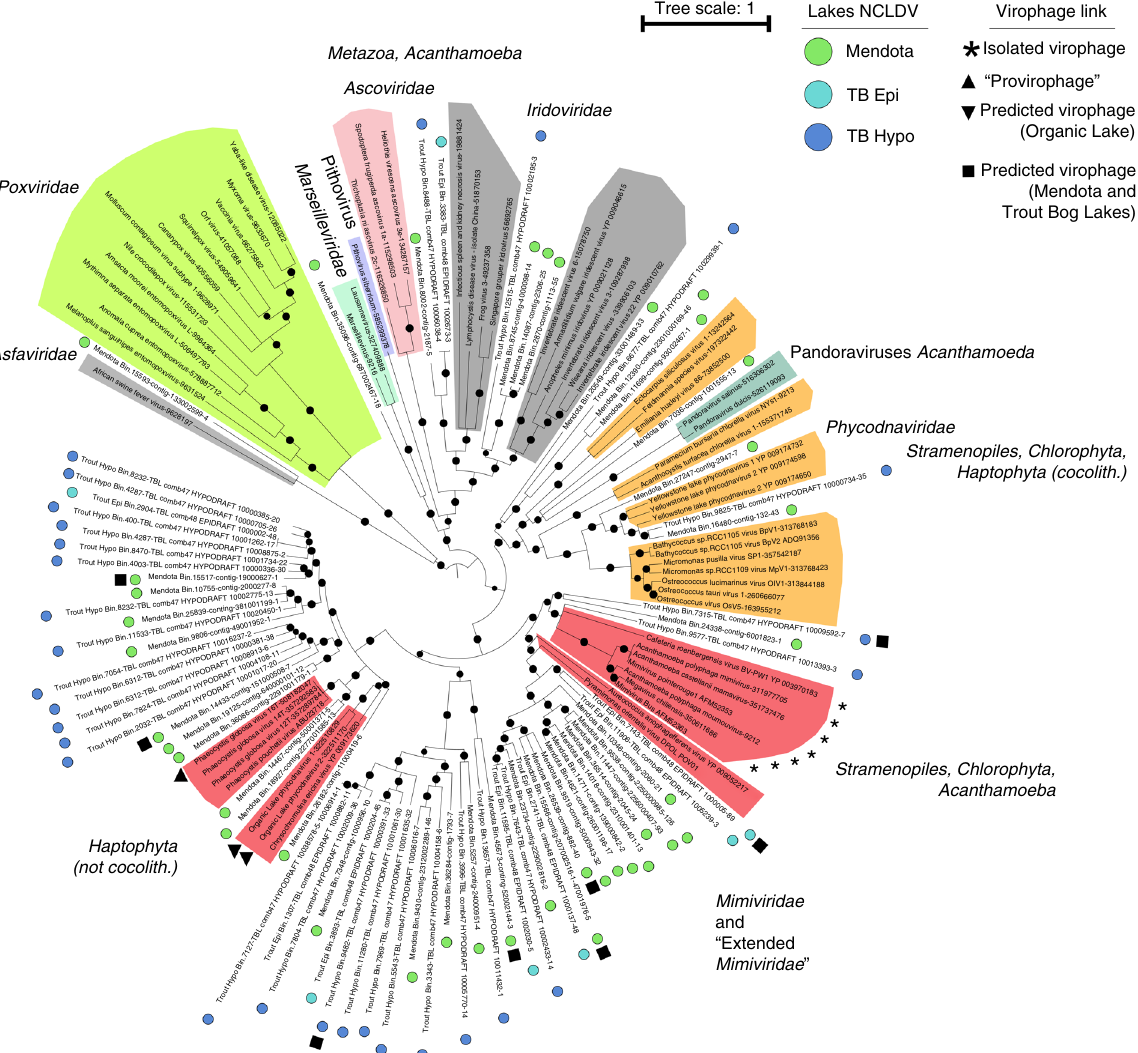
Fig. 6 NCLDV diversity in Lake Mendota and Trout Bog Lake, and predicted associations to virophages. The maximum-likelihood tree was computed from a DNA PolB multiple alignment. All branches with support < 0.5 were collapsed. NCLDV clades are highlighted in colors, and associated with the host range based on the clade isolated members. Metagenomic sequences from Lake Mendota and Trout Bog Lake are highlighted with a colored circle. NCLDV associated with virophages are indicated with black shapes (either isolated virophages, the ‘ provirophage ’ from Phaeocystis globosa virus 16T 6 , Organic Lake NCLDV 15 , or metagenomic sequences from Lake Mendota and Trout Bog Lake co-occurring with